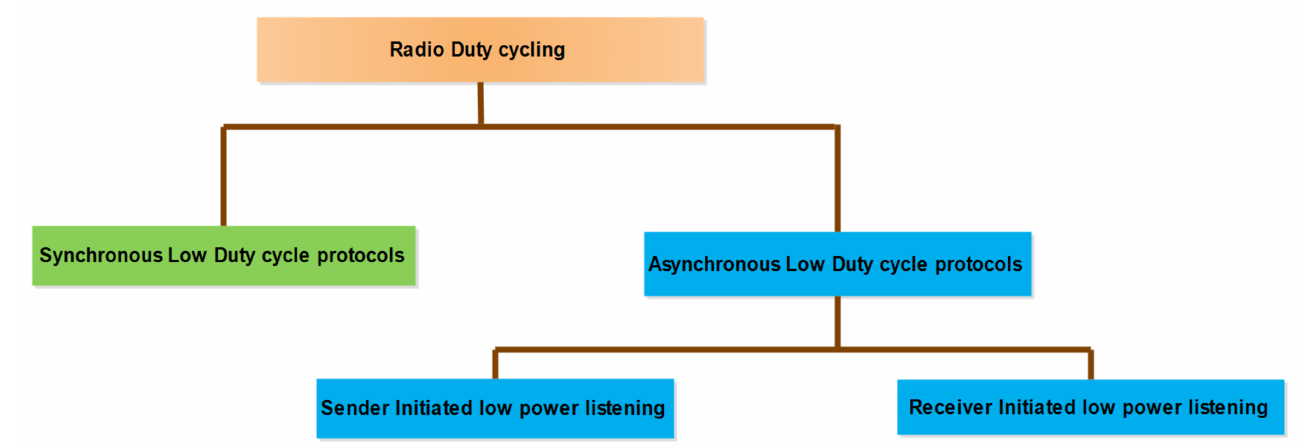
Figure 11. Proposed classification for radio duty cycle